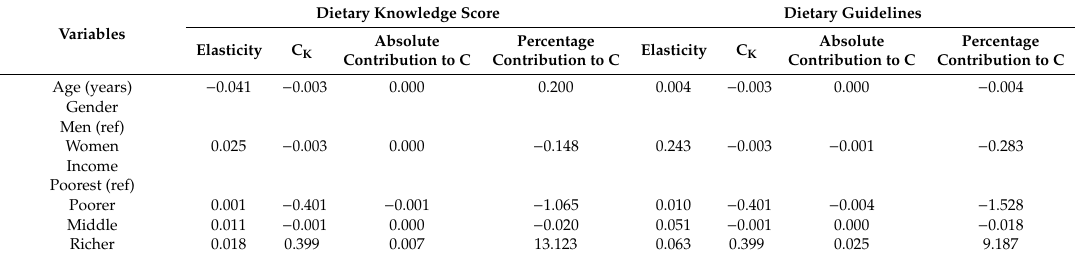
Table 5. Decomposition analysis of the concentration indexes on the dietary knowledge score and dietary guideline awareness.